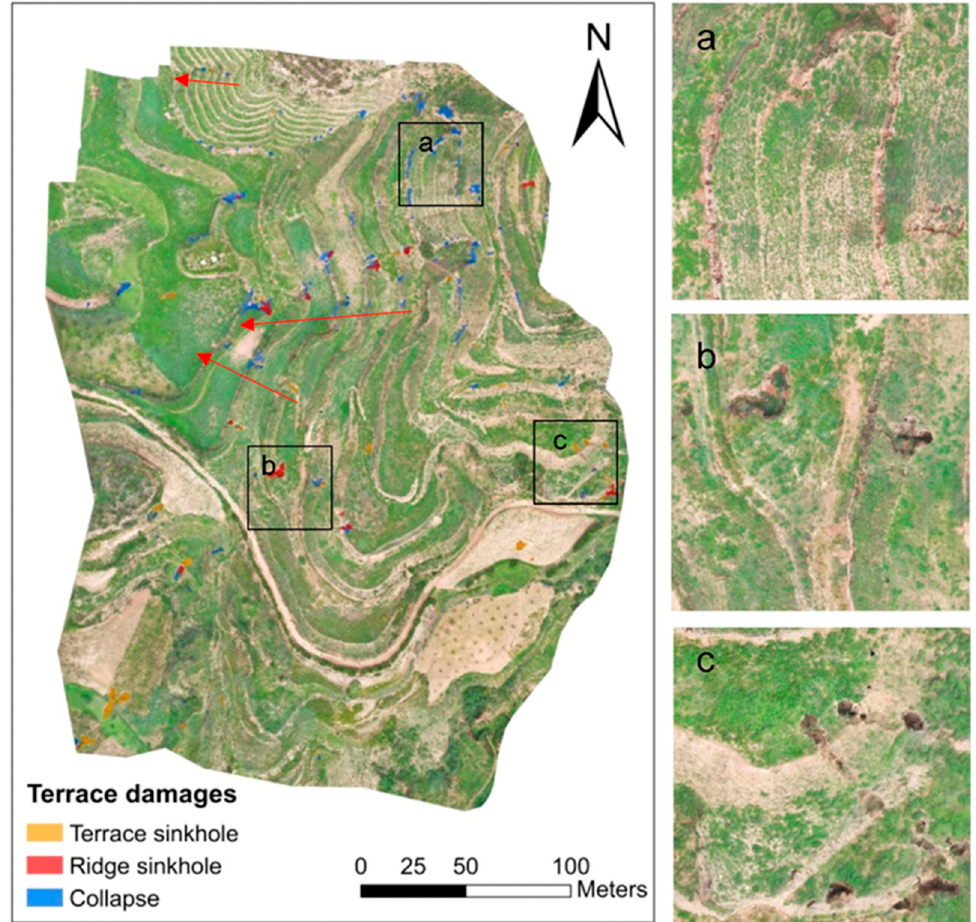
Figure 7. Classification result. The left figure is the classification map of terrace damages, and the three figures on the right show the images without overlapping classification results within the box area of the left figure. The red arrow shows the terrace damages are continuously distributed along the slope.